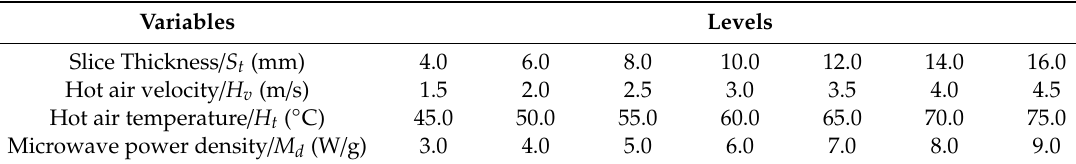
Table 1. Variables and levels in single factorial